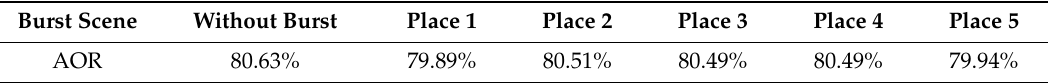
Figure 8. AOR values with di ff erent number of sensors. Table 7. AOR with a pipe